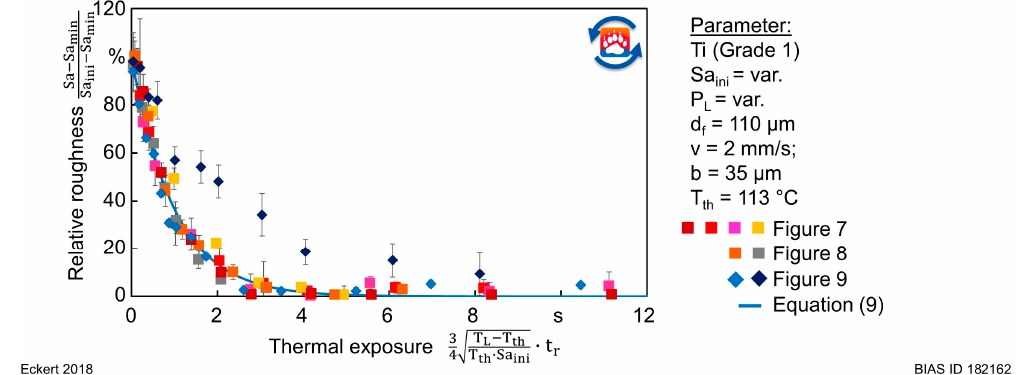
Figure 13. Process Signature Component of LCP on titanium as an example of a multi-cycle load.